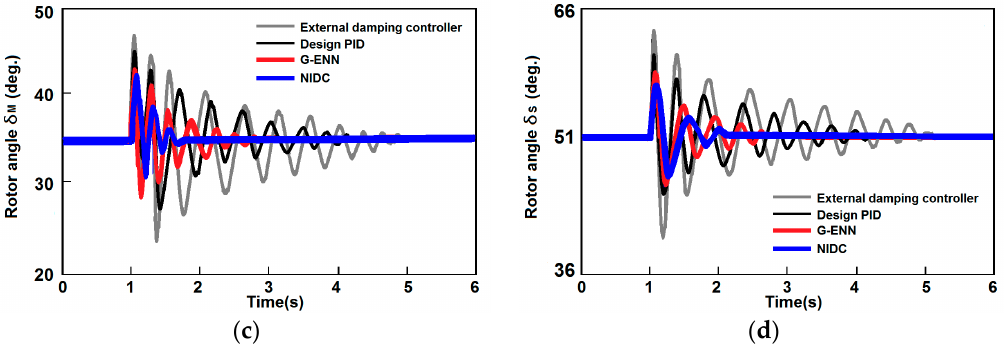
Figure 8. The responses of transient stability for the generators of hybrid power multi-system in Case 1 ( a ) The generator speed of MTG; ( b ) The generator speed of SG; ( c ) The rotor angle of MTG; ( d ) The rotor angle of SG.